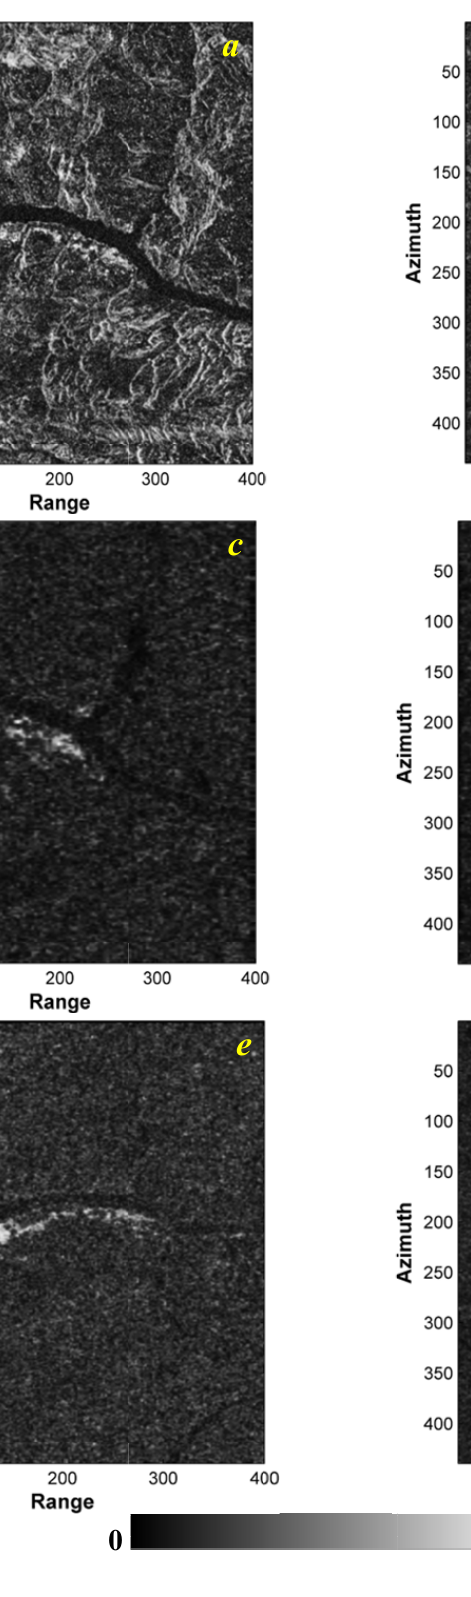
s from th ble 1.